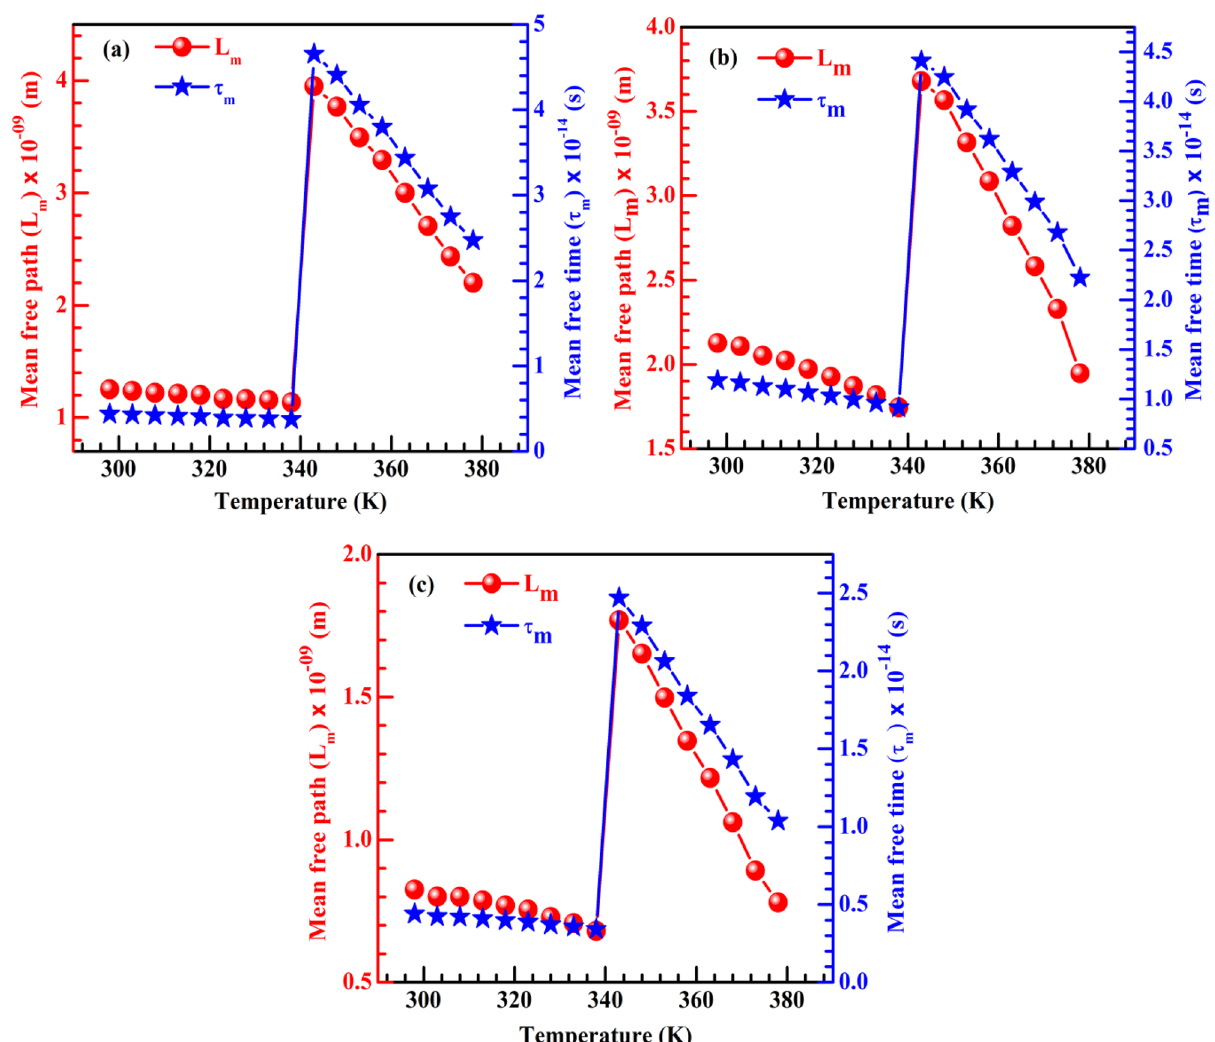
Figure 5. Mean free path and mean free time of CH 3 NH 3 PbI 3−x Cl x . Mean free path and mean free time at different temperature region for ( a ) CDC, ( b ) spray and ( c ) dipping deposited CH 3 NH 3 PbI 3−x Cl x thin